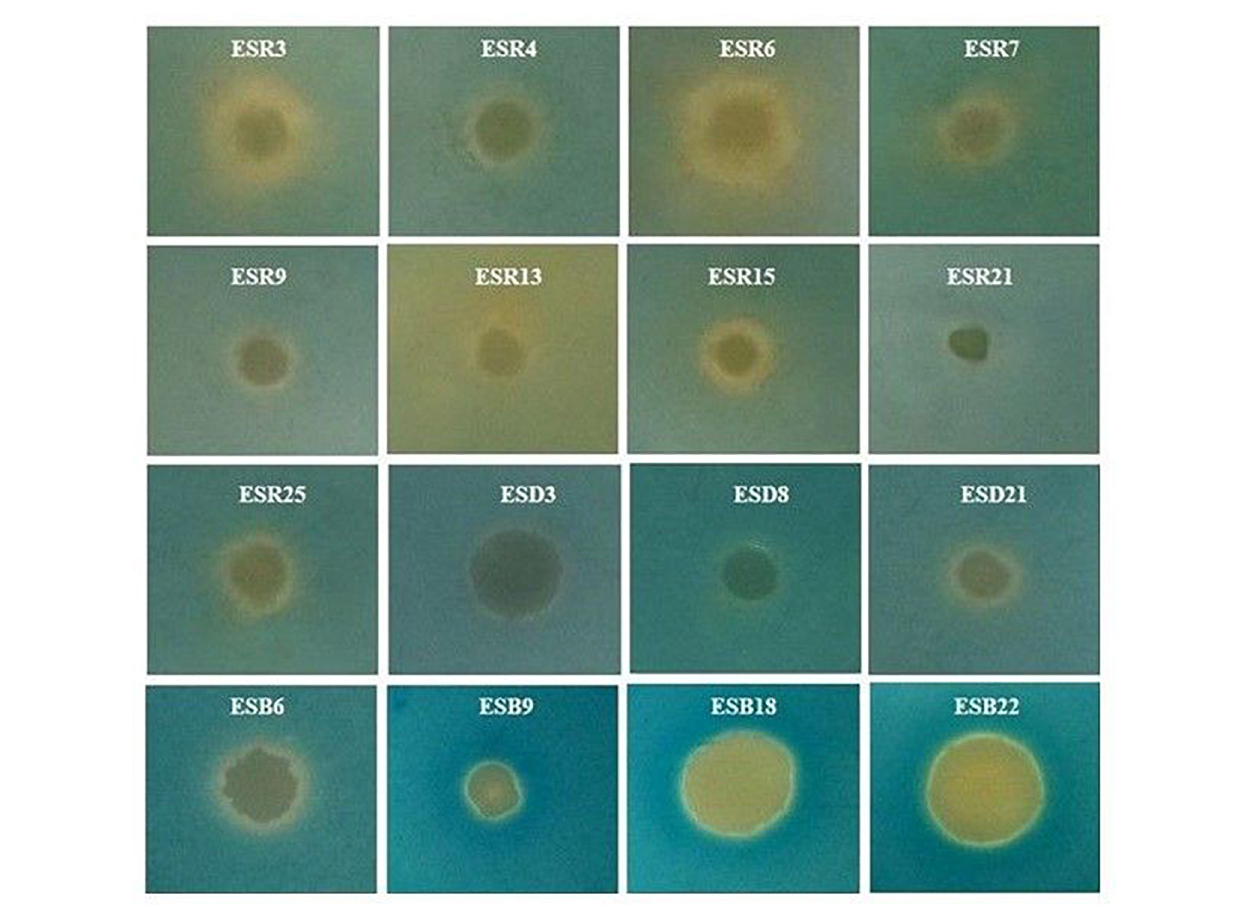
FIGURE 7 | Expression of siderophores. Each bacterium (2 µ L, ca. 10 7 CFU mL − 1 ) was spotted onto the center of the LB agar plates and incubated at 28 ◦ C for 20 h. Then, 10 mL O-CAS broth was added over those LB agar plates and kept at 28 ◦ C in static conditions for 10 h. Photographs represent one of three experiments, which gave similar